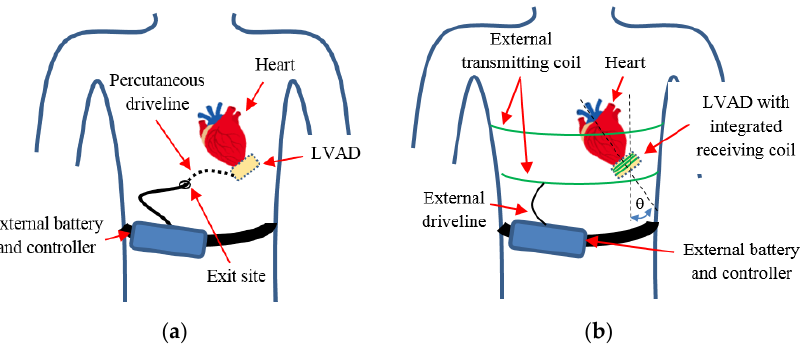
Figure 1. Configuration of a traditional powered left ventricular assist device (LVAD) using ( a ) percutaneous driveline cable and ( b ) with integrated wireless power system. The angle θ is the inclination of the LVAD with respect to the axis of the primary coil.